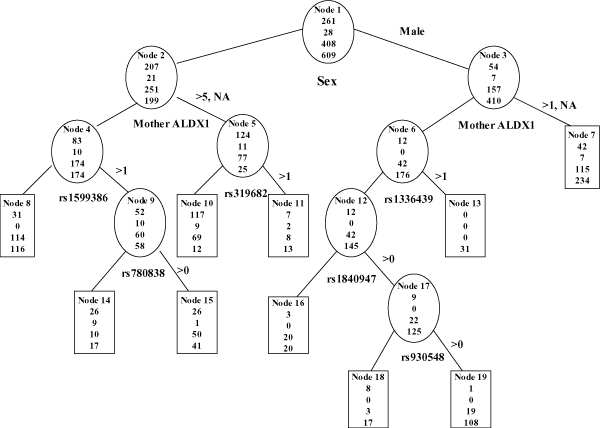
The pruned tree at the significance level of 0.00001 for ALDX1 using Illumina SNP data. We use circles and boxes to represent internal and terminal nodes, respectively. Under each internal node is the covariate that is used to split the node. Inside each node and from top down are the node number, the numbers of pure unaffected individuals, never drink individuals, unaffected individuals with some symptom, and affected individuals.